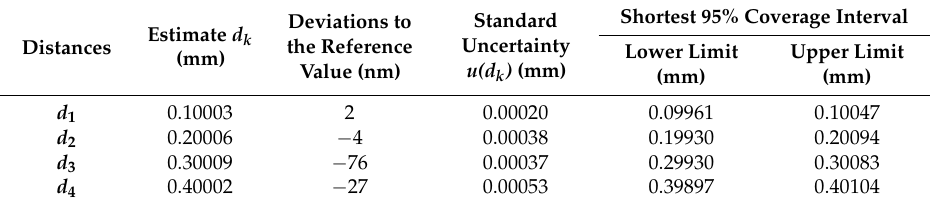
Table 3. Measurement results of the glass line scale in horizontal position. Hypothesis 1.